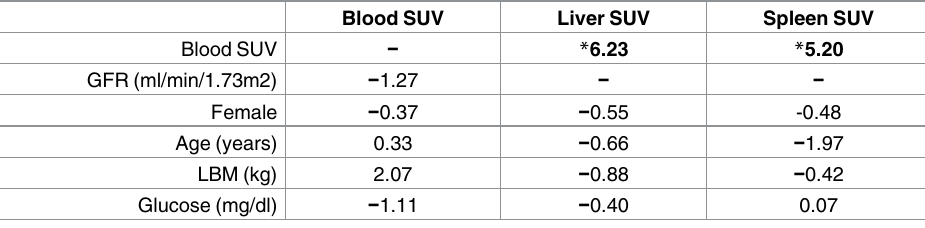
Table 2. Multivariate regression models of confounding variables associated with blood, liver, and spleen activity. Columnheadersare dependent variablesand rows are covariates. Blood